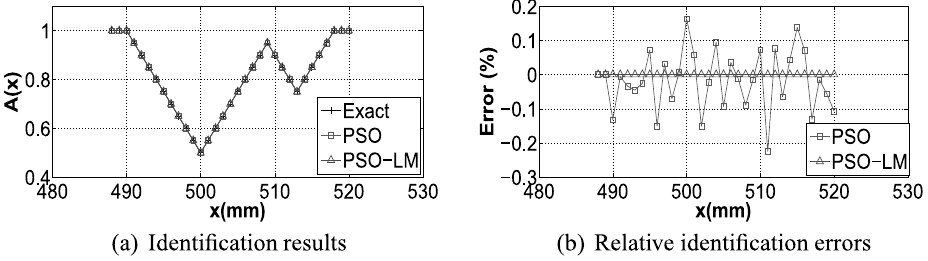
Fig. 7. Identi fi cation with noiseless data for Case 3 and the short rectangular pulse excitation.